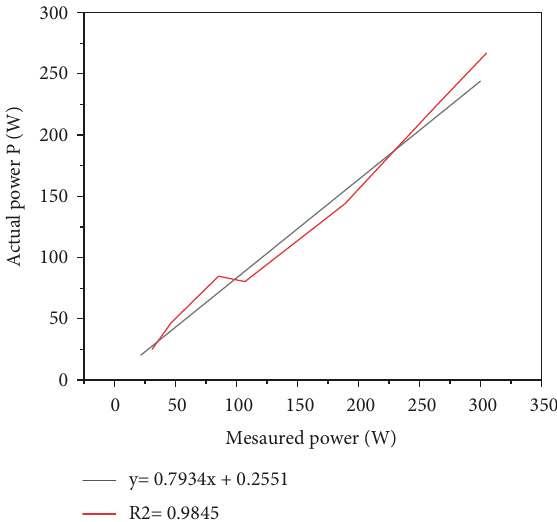
Figure 5: The relationship between the time power P and the measured power p